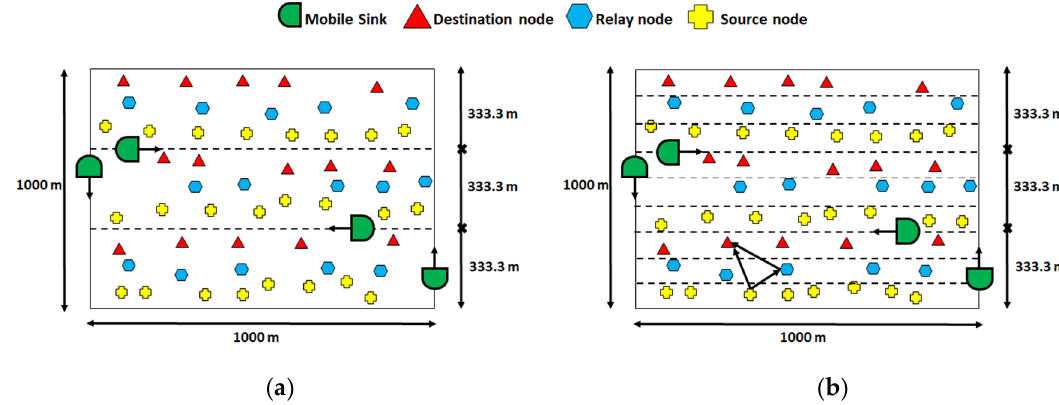
Figure 5. Division of a network area into regions and sub-regions. ( a ) Division of field into regions; ( b ) Division of field into sub-regions.